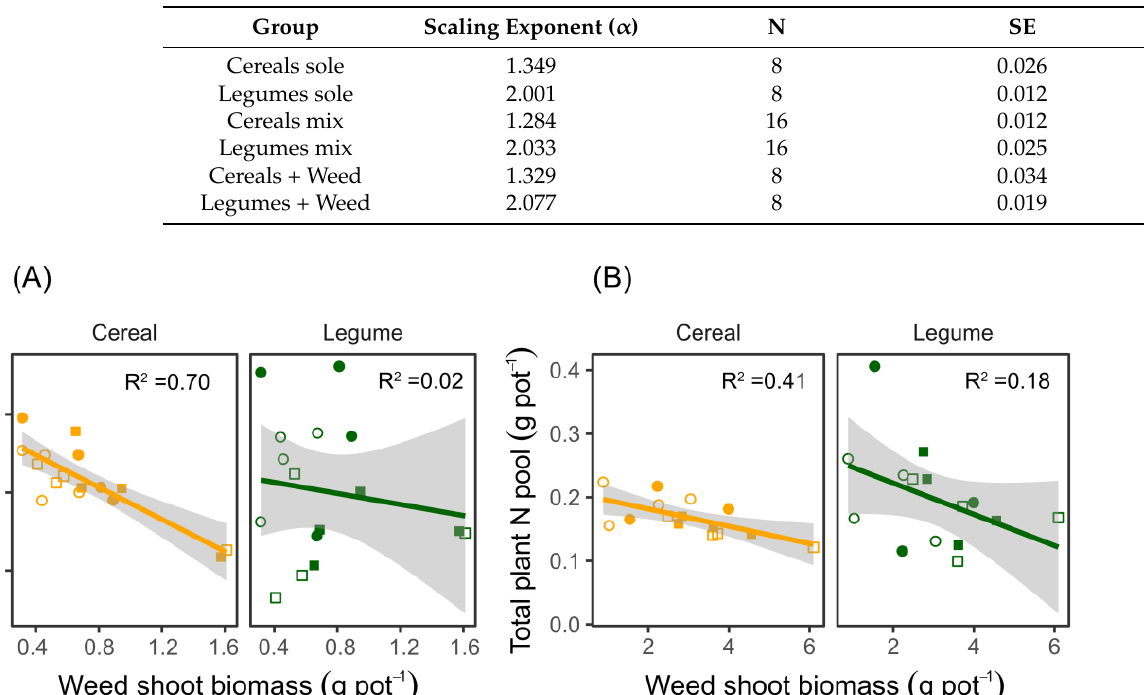
Figure 5. The mean ( A ) head height for wheat and ( B ) pod weight for two faba bean cultivars pot- grown as sole crops and in mixture, with and without the weed C. album at maturity. The error bars represent ±1 SD of the different cultivar combinations. The cultivars whose names appear in bold